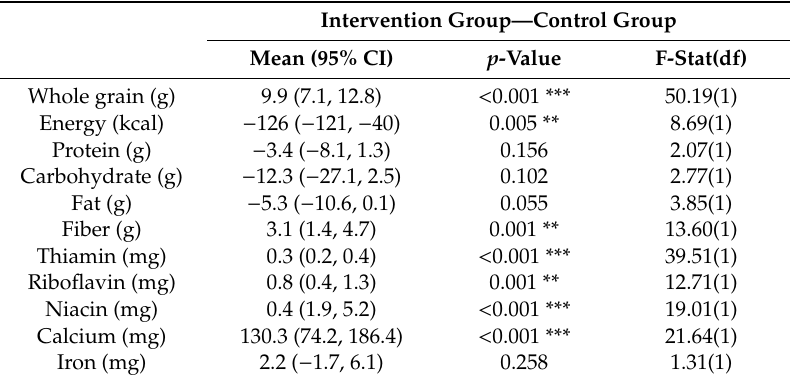
Table 3. Comparison of whole grain and nutrient intakes over nine months between intervention and control groups ( n =